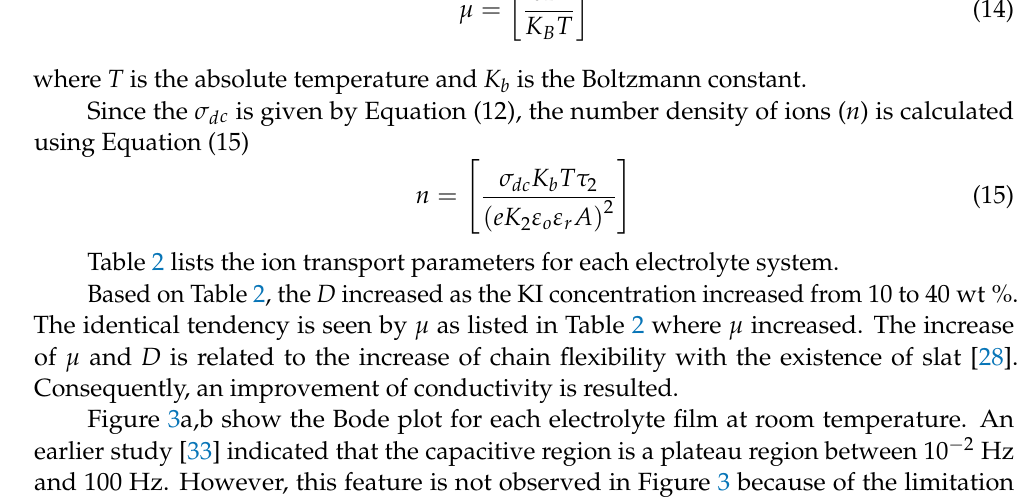
Table 2. Numerical values of σ dc , D , µ , and n at ambient temperature